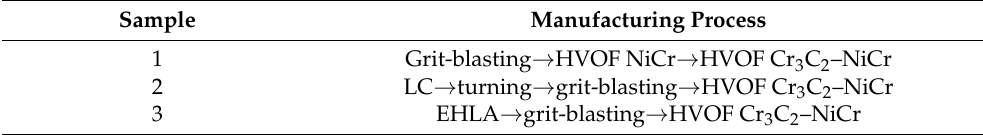
Table 3. Process routing of experiment sample.